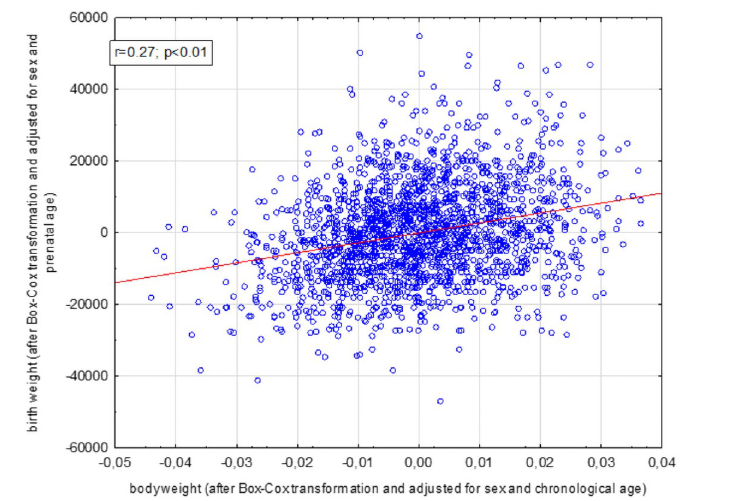
Fig 3. Relationship between birth weight and body weight among children aged 13–16.